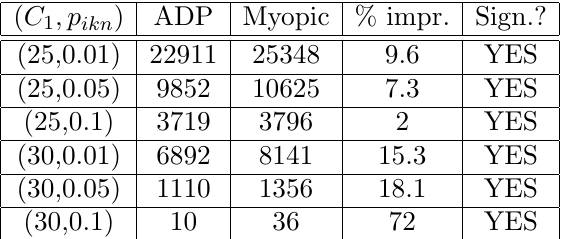
Table 2. Results for the relaxed tol- erance case with N = 10.